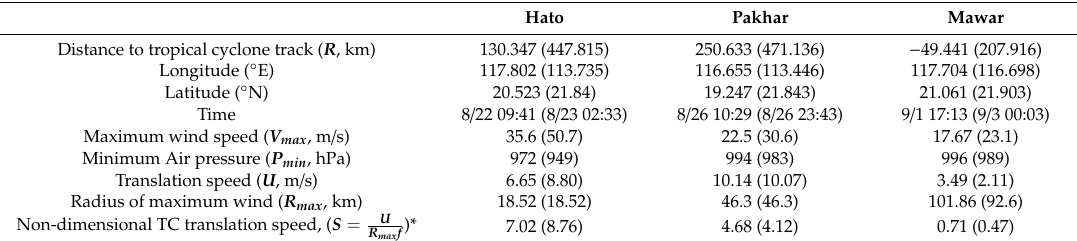
Table 1. Information of Hato, Pakhar, and Mawar when closest to the wave glider and when the tropical cyclone (TC) was strongest (in brackets) during the observation. Positive (negative) values of the distance to tropical cyclone track refers to the right (left) side of the track. Hato Pakhar Mawar Distance to tropical cyclone track ( R ,